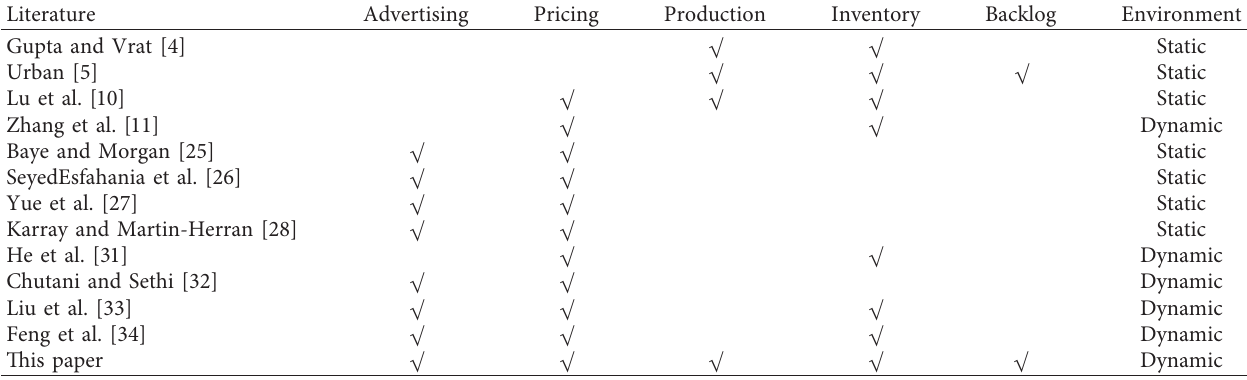
Table 1: Contemporary literature